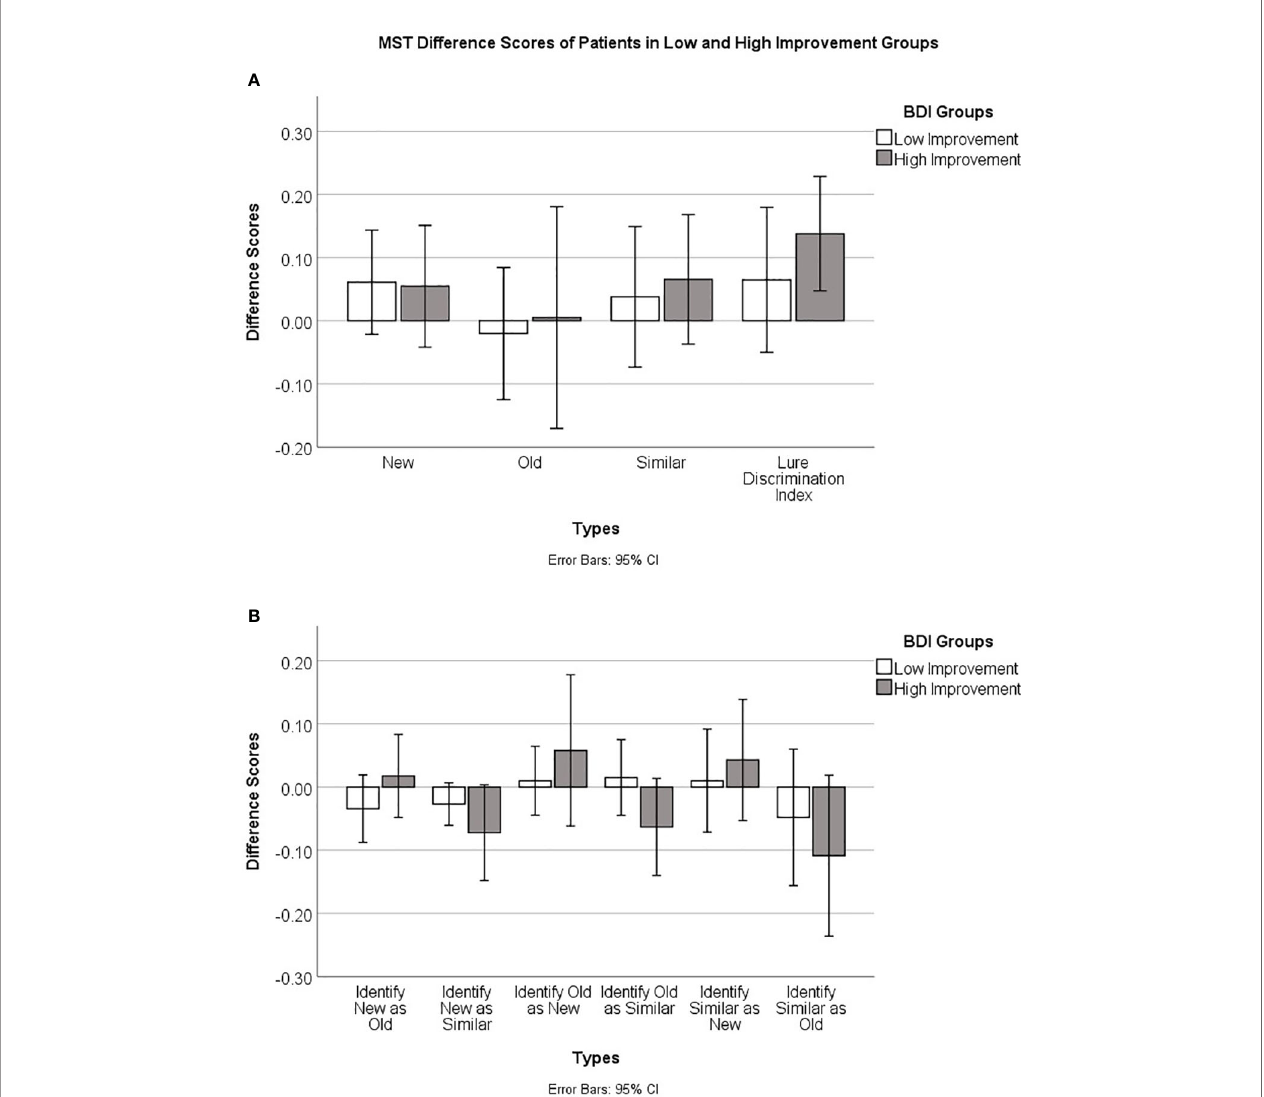
FIGURE 3 | (A) Baseline to end of study accuracy difference scores (End of study – Baseline), and 95% con fi dence intervals, on the Mnemonic Similarity Test for patients who had lower versus higher clinical improvement based on BDI-II clinical cut-off scores (see text for details). (B) Baseline to end of study error difference scores (End of study – Baseline) and 95% con fi dence intervals for the different error types on the Mnemonic Similarity Test for patients who had lower versus higher clinical